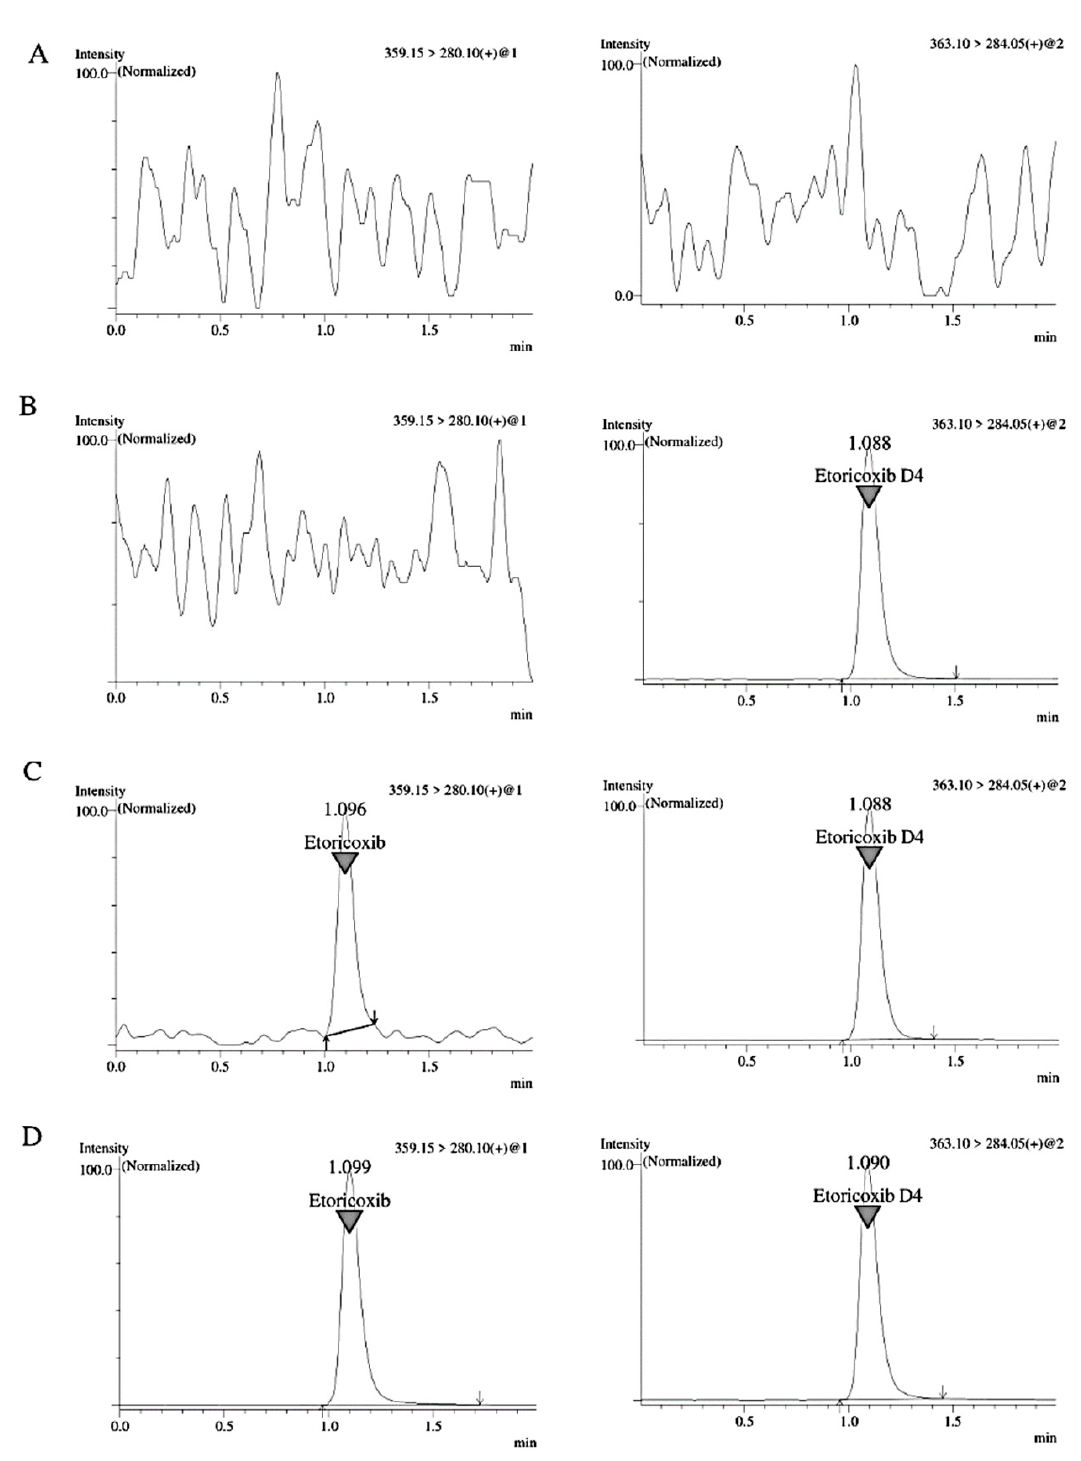
Figure 2. Mass chromatograms of ( A ) blank sample, ( B ) zero sample, ( C ) LLOQ of etoricoxib (10.00 ng/mL) and ( D ) a subject’s sample at 2400.45 ng/mL concentration. Etoricoxib plasma calibration curves were linear with correlation of determinations (r 2 ) of 0.9967–0.9996 over concentration range of 10.00 to 4000.39 ng/mL. The relative error (RE, %) for all the calibration points was ± 10.89% of their nominal concentration which was within the acceptance limit. Carry-over was not found in the blank human plasma sample which was injected after ULOQ sample. The within- and between-run precision and accuracy results are shown in Table 2. The precision (CV, %) and within-run accuracy (bias, %) of QC samples (including LLOQ) ranged from 0.64% to 16.67% and − 4.19% to 7.04%. Between-run precision (CV, %) and accuracy (bias, %) values ranged from 2.25% to 13.74% and − 1.68% to 5.86%, respectively. The etoricoxib maximum batch-run precision (CV, %) and accuracy (bias, %) results of ≤ 6.75% and ≤ 8.77% showed that the method would be suitable for an analytical batch-run with maximum run time of 250 min. The precision and accuracy results show that the method is precise and accurate.